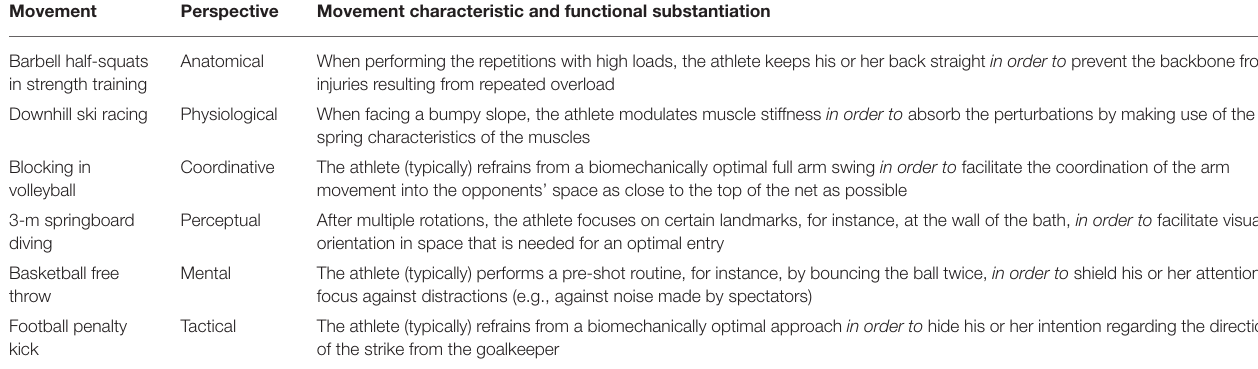
TABLE 2 | Non-biomechanically substantiated characteristics of sports movements. Movement